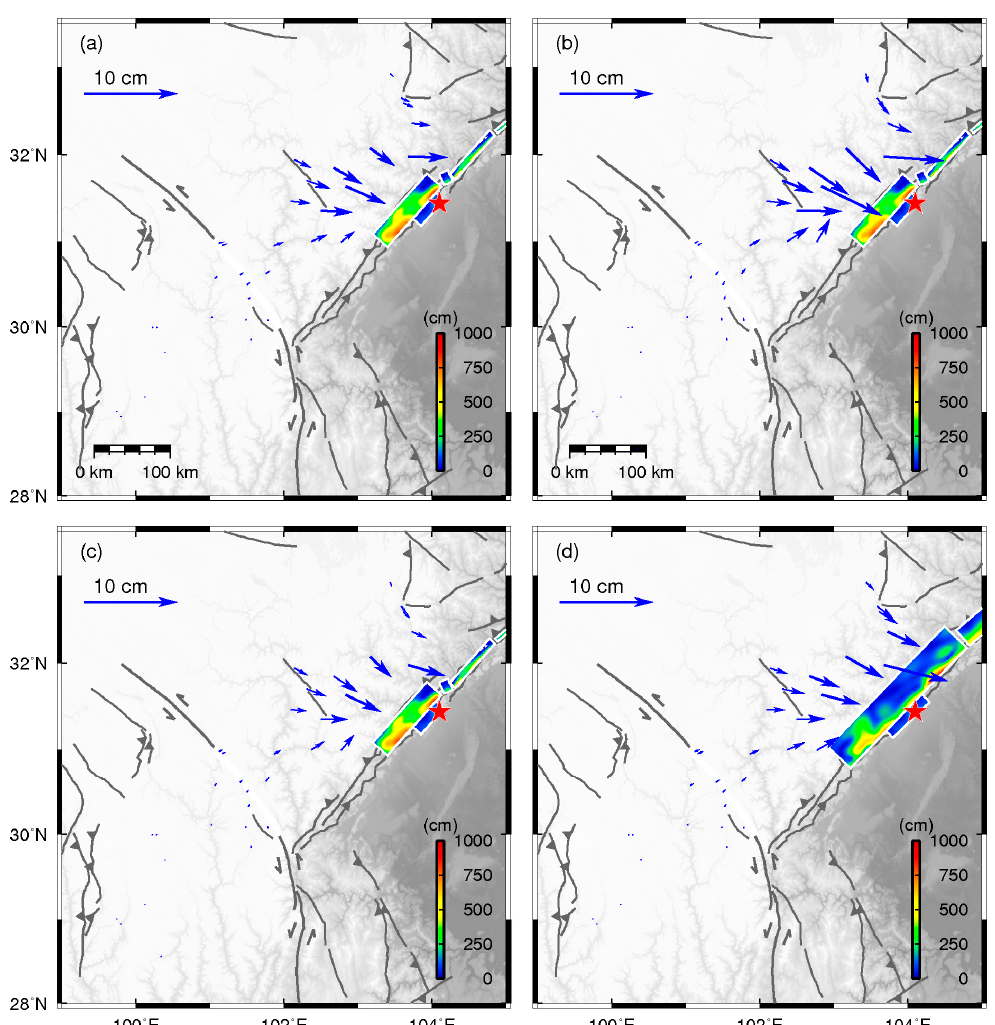
Figure 4. Cumulative post-seismic relaxation effect and slip model of the 2008 M w 7.9 Wenchuan earthquake. The model with ( a ) original parameters; ( b ) different viscosities of lower crust (2.0 × 10 19 Pa ∙ s) and upper mantle (5.0 × 10 19 Pa ∙ s); ( c ) different effective elastic thickness (14 km); and ( d ) different slip model (Diao et al. [48]). Blue arrows indicate the impact of the earthquakes in the studied region, and the red star represents its epicenter.